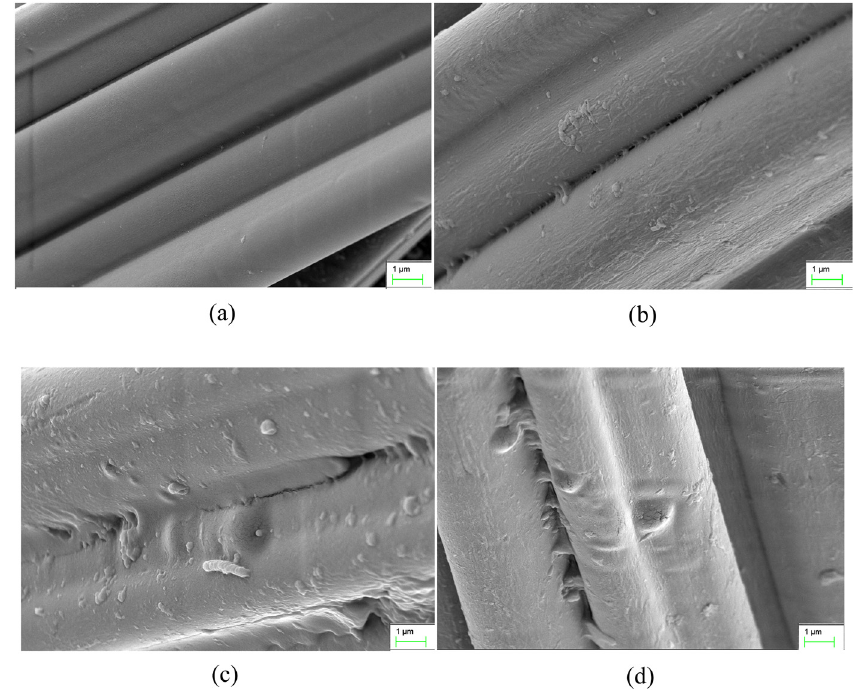
Figure 3: The outer surface of the fi ber. The magni fi cation of the image is 20k times. ( a ) Viscose fi ber, P = 0. ( b ) Spun - dyed viscose fi ber, P = 76.96. ( c ) Spun - dyed fi ber, P = 153.92. ( d ) Spun - dyed fi ber, P =